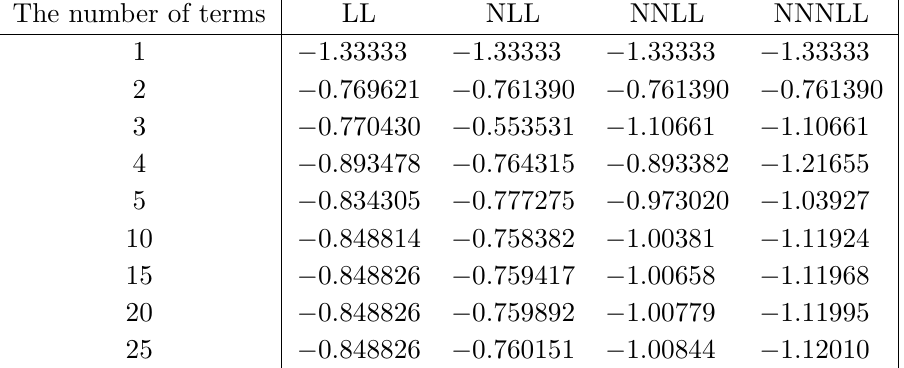
from truncated perturbative series of the 1 = 2